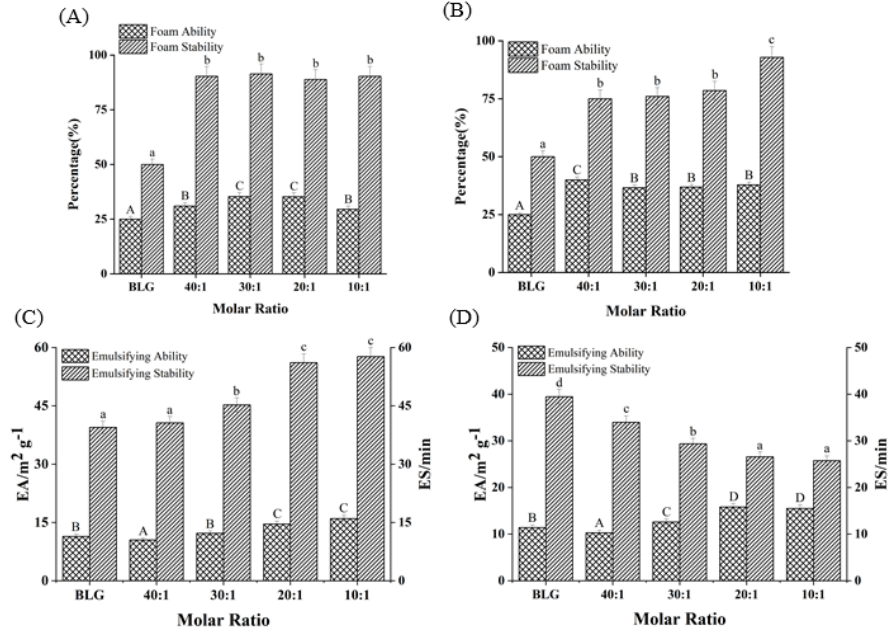
Figure 7. Effects of different molar ratios of Bai–BLG ( A ) and Chr–BLG ( B ) systems on foam ability and foam stability. Effects of different molar ratios of Bai–BLG ( C ) and Chr–BLG ( D ) systems on the emulsifying ability and emulsifying stability. The molar ratios of BLG to Bai or Chr were 40:1, 30:1, 20:1, and 10:1.